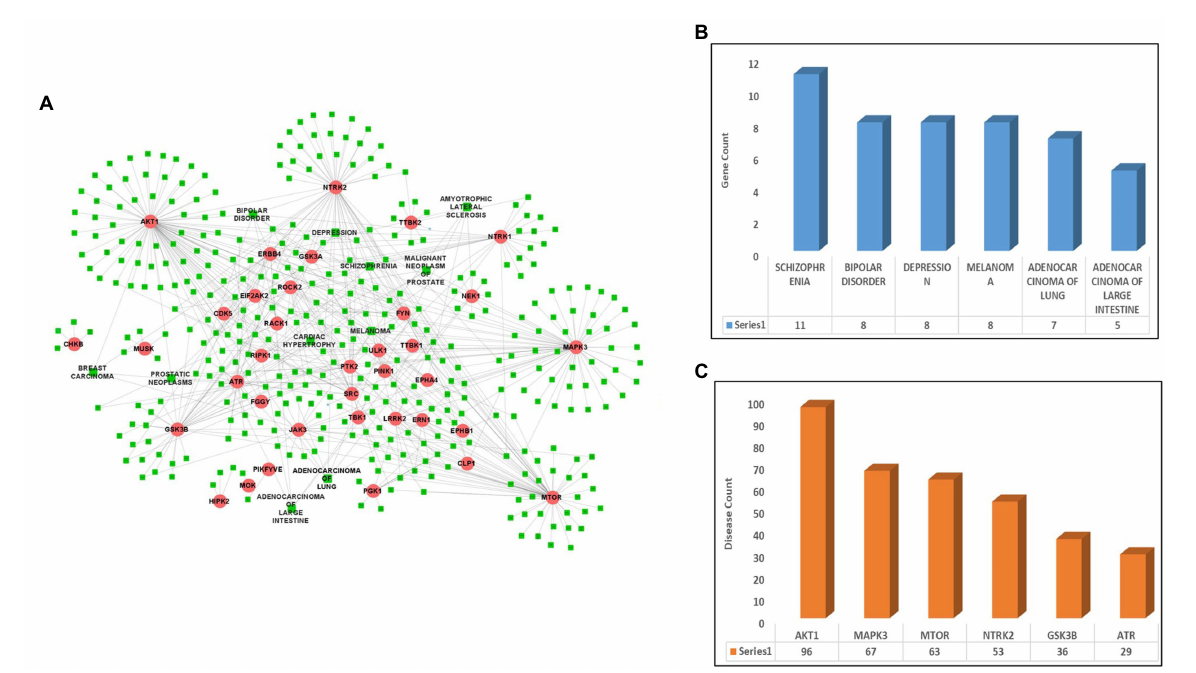
FIGURE 1 Disease-kinase interaction network. (A) ALS-associated 36 Kinases (Red) show interaction with the human diseases along with ALS (Green). (B) Bar plot representing the highest number of genes associated with the disease. (C) Bar plot representing the highest number of diseases associated with the